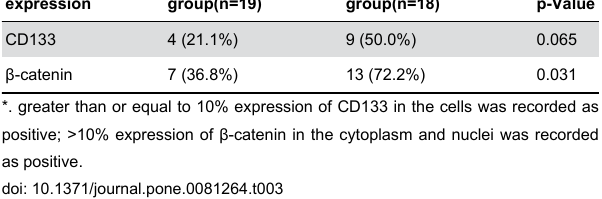
reach a significant level (p=0.056 ). There is no significant correlation between β-catenin and the pathological type of CRC (p=0.335).